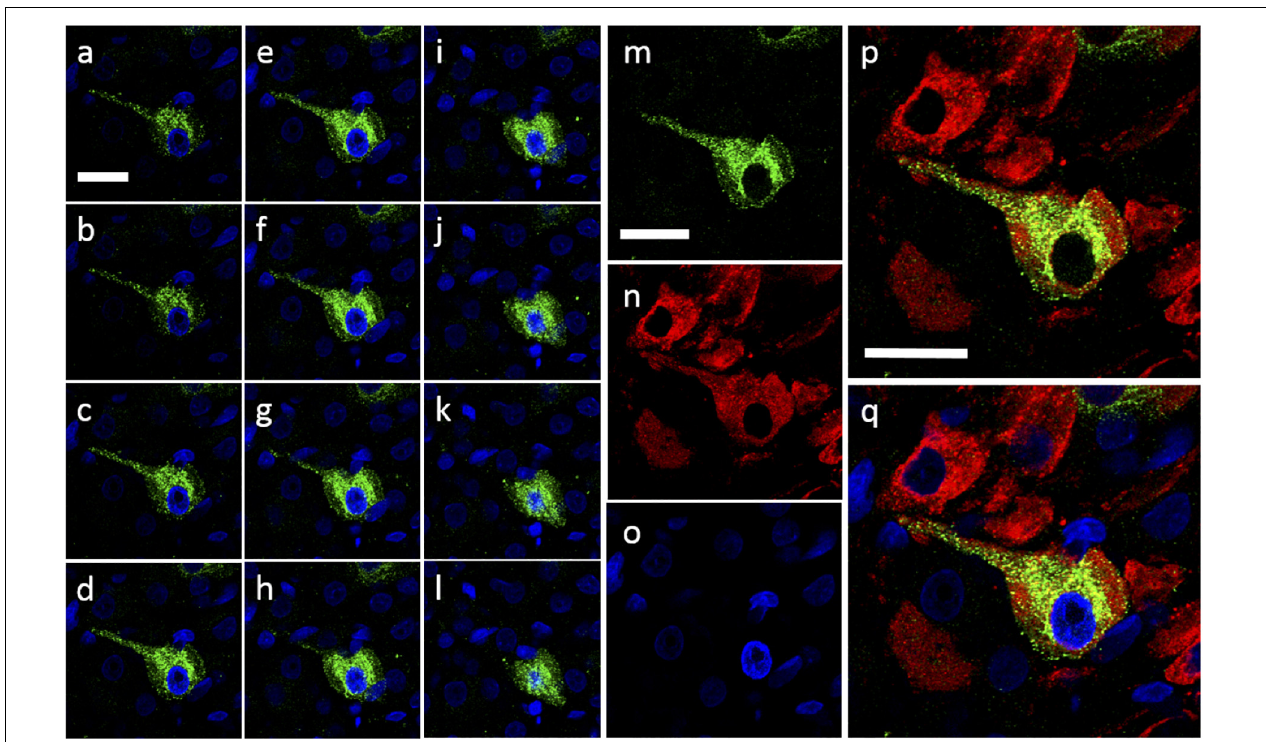
FIGURE 10 | Intracellular Urocortin expression within cells of the caudal SON. (a–l) Coronal z-stack sequence (progressing caudal-rostral) through cell within the caudal rat hypothalamic area. Ucn expression (green) can be clearly seen within cell body as well as suggested dendritic projection from cell body. Absence of Ucn nuclear staining was confirmed through the use of DAPI (blue). (m–q) Snapshot of previous section (e) showing; Ucn (green) alone (m) , VP (red) alone (n) , DAPI (blue) alone (o) , Ucn + VP (p) and Ucn + VP + DAPI (q) . Ucn, urocortin; VP, arginine vasopressin; DAPI, 4 (cid:48) ,6-diamidino-2-phenylindole. Scale Bar = 25 µ